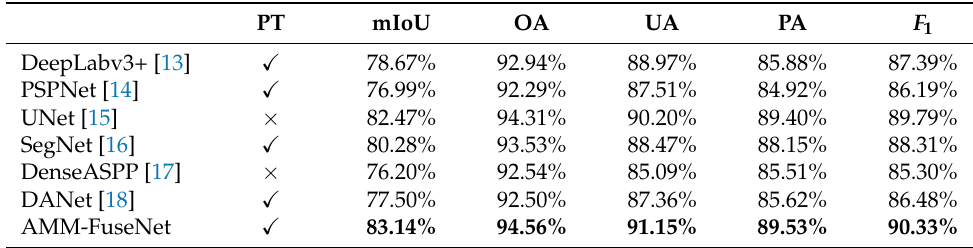
Table 8. Performance comparison for DFC2020 (Sentinel-2 and Sentinel-1) dataset. ( (cid:88) : pre-trained (PT) and × : not PT backbone).